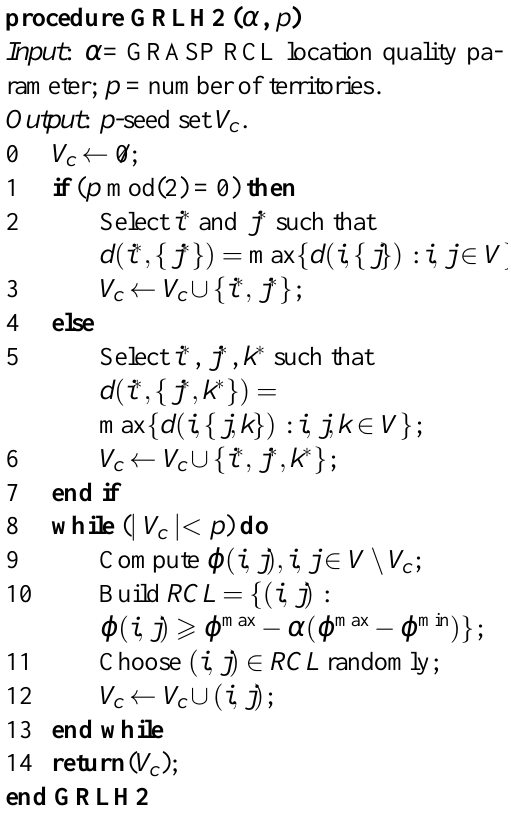
Fig. 3. Location procedure